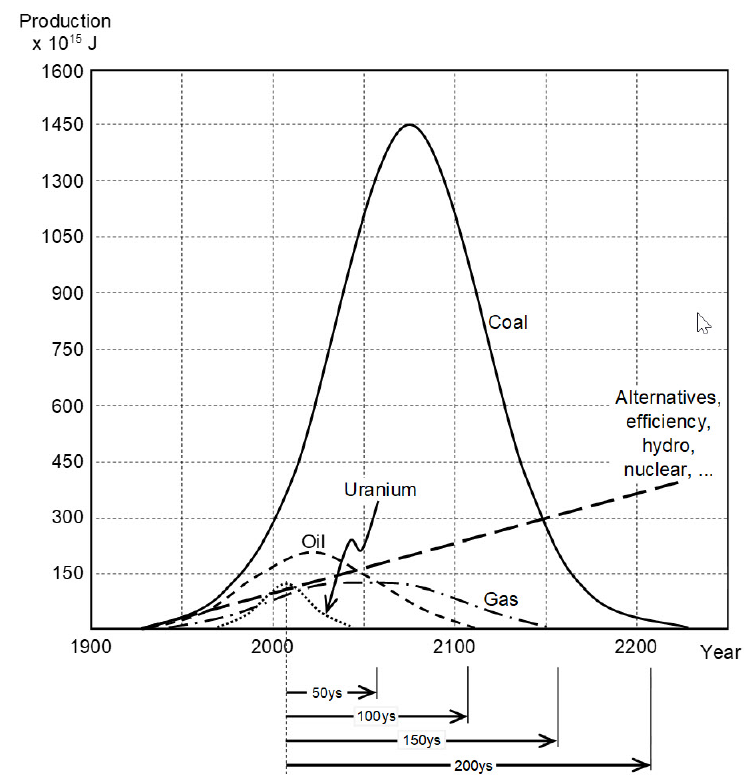
Figure 1. Energy depletion